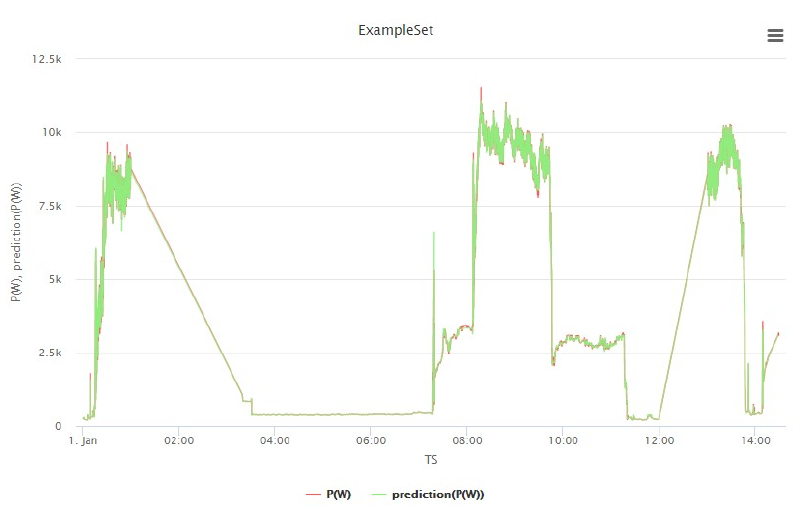
Figure 20. Visualization graph of RF model.